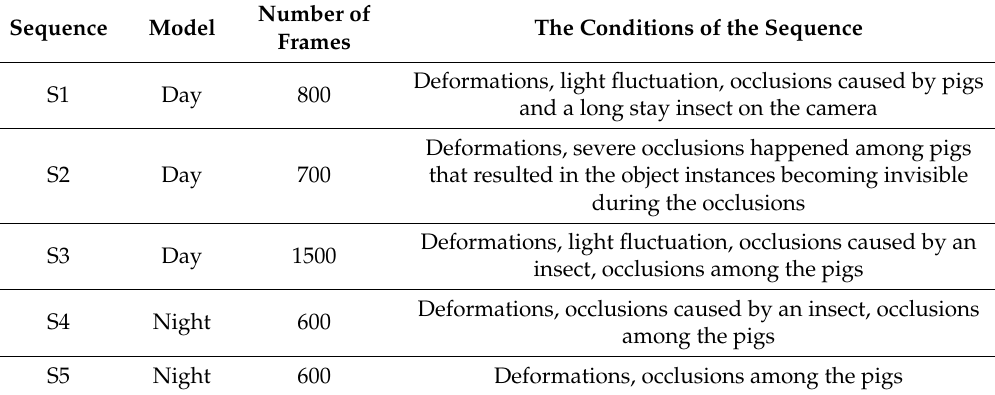
Table 1. A summary of the testing sequences.